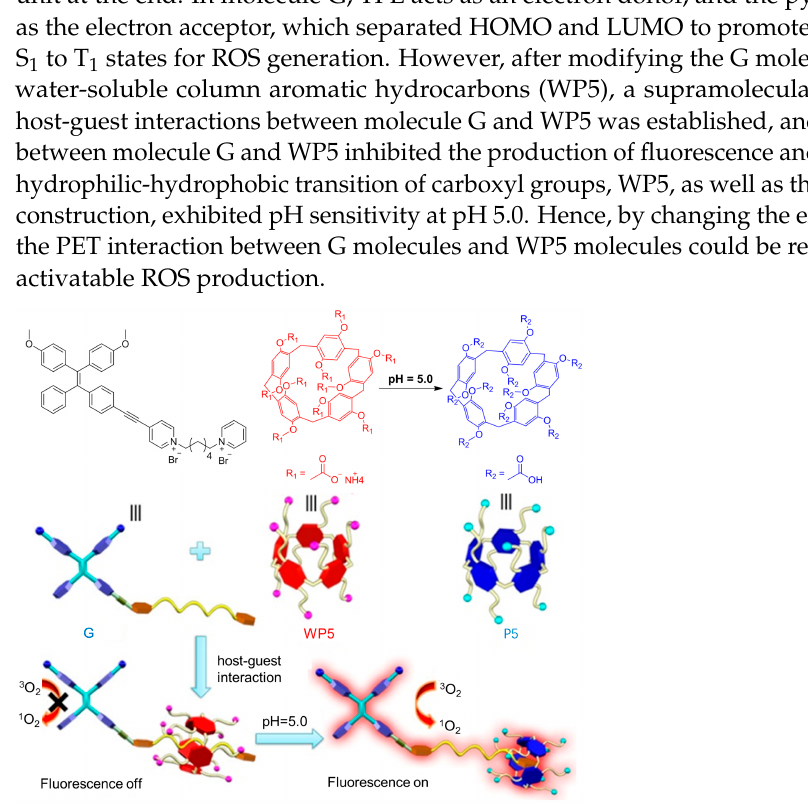
Figure 10. Molecular structure and schematic illustration of the molecule of WP5, P5, and G, and the proposed mechanism of pH activation of PDT. Reprinted with the permission of the authors of [66]. Copyright 2020, Wiley-VCH GmbH.